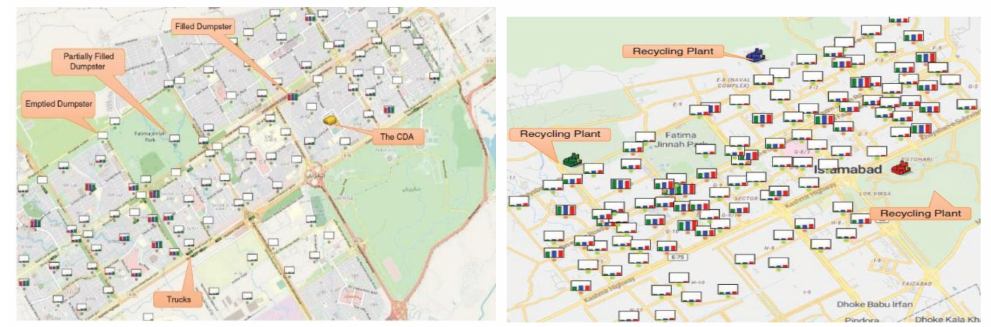
Figure 14. Waste transportation architecture